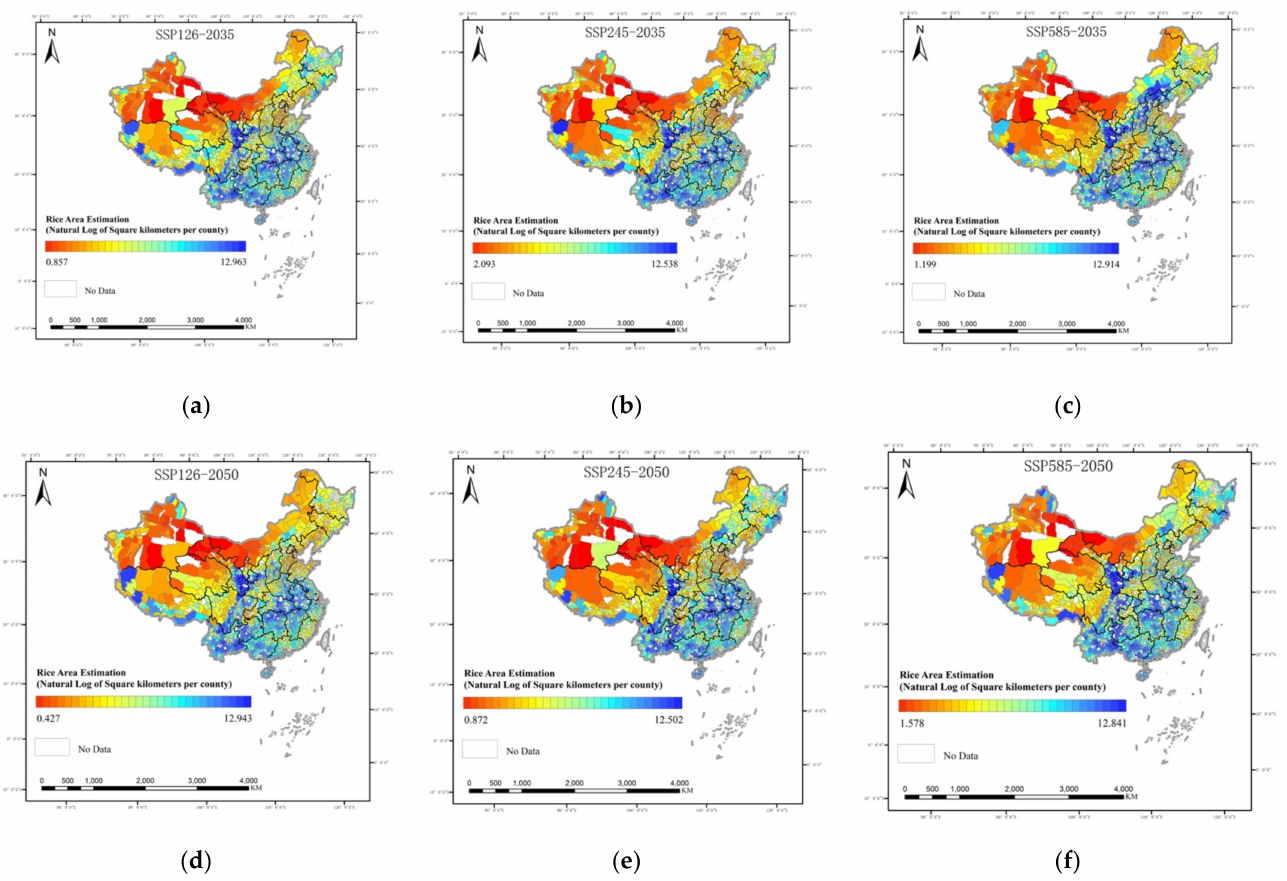
Figure 6. Spatial pattern of rice in China under ( a ) SSP126 in 2035, ( b ) SSP245 in 2035, ( c ) SSP 585 in 2035, ( d ) SSP126 in 2050, ( e ) SSP245 in 2050 and ( f ) SSP585 in 2050